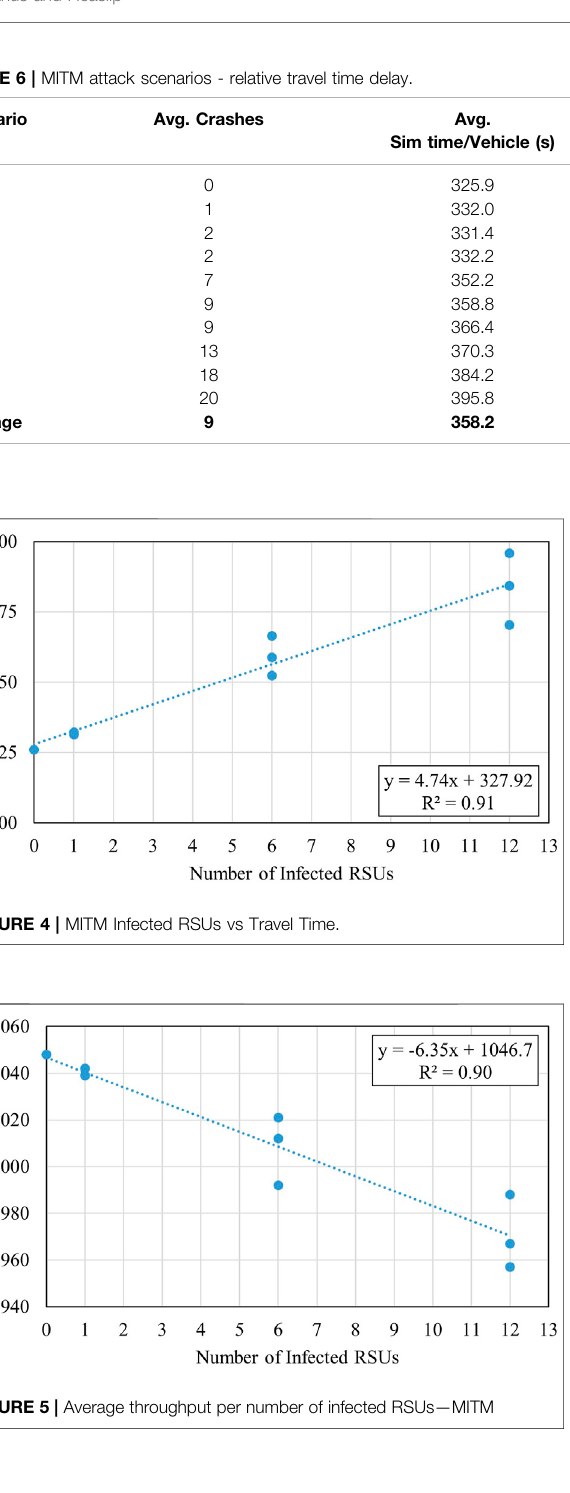
Frontiers in Future Transportation |